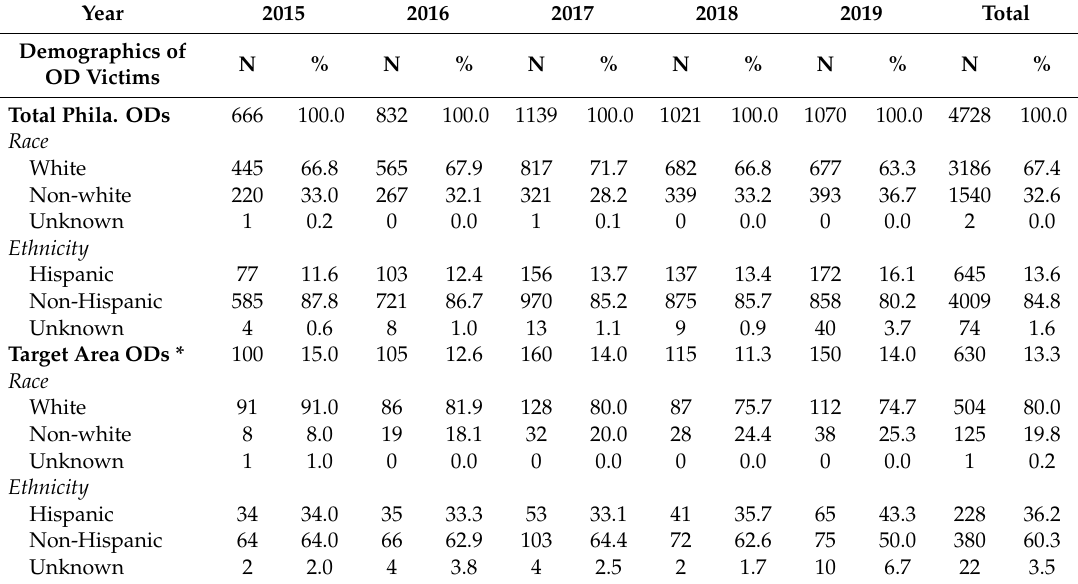
Table 1. Number of ODs in the Target Area and Citywide, by